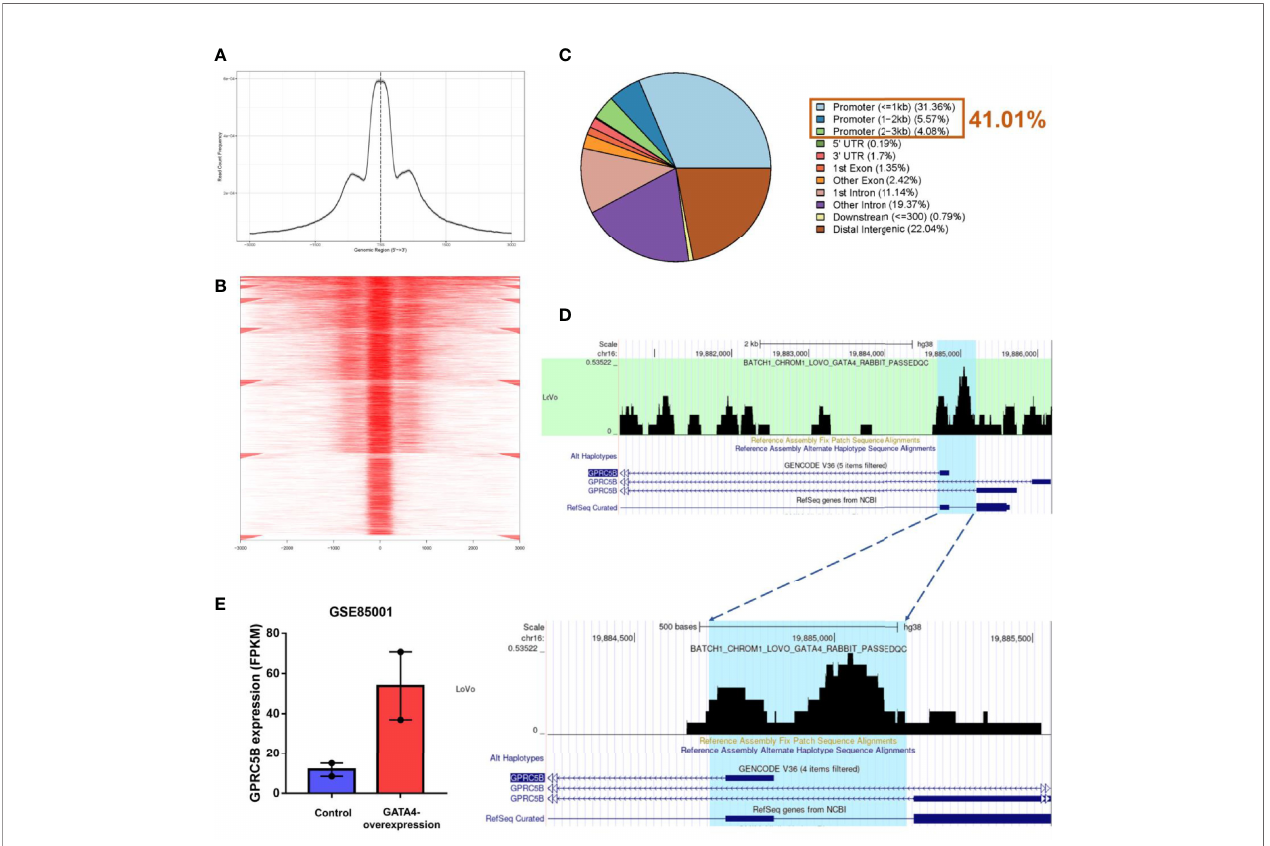
FIGURE 6 | (A) Visualization of read count frequency of peaks revealed that they were primarily located around the TSS. (B) Peaks are mapped to the TSS regions and further aligned in a tagMatrix, indicating that the majority of chromatin accessibilities were near the TSS. (C) Pie plot reveals that most of the open chromatin regions were located in promoters. (D) GATA4 ChIP-seq data show the strong overlap between the GATA4 protein binding regions and the predicted regions (highlighted in blue). GATA4 could physically bind to the GPRC5B promoter at chr16: 19884686-19885185. (E) According to the GEO database (GSE85001), GPRC5B was signi fi cantly upregulated in the GATA4-overexpression group. TSS, transcription start site; ChIP-seq, chromatin immunoprecipitation sequencing; GPRC5B, G protein-coupled receptor class C group 5 member B; GEO, Gene Expression